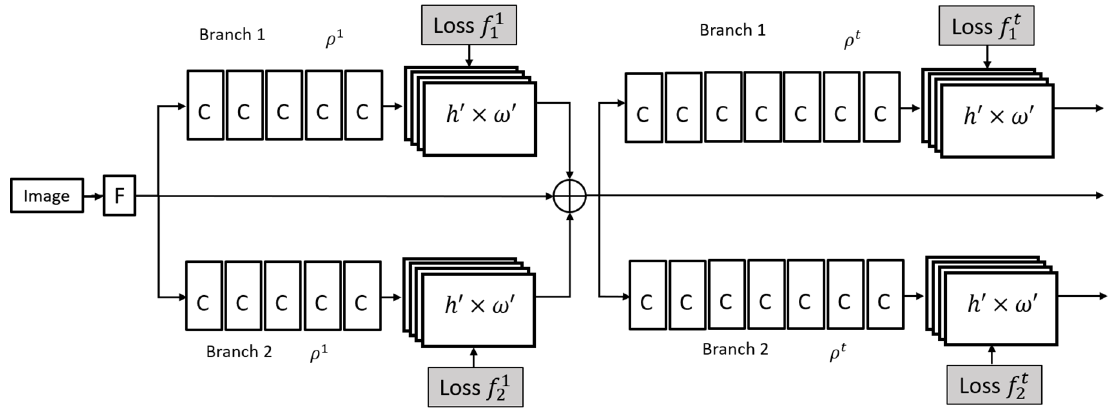
Figure 5. The structure of the OpenPose model.